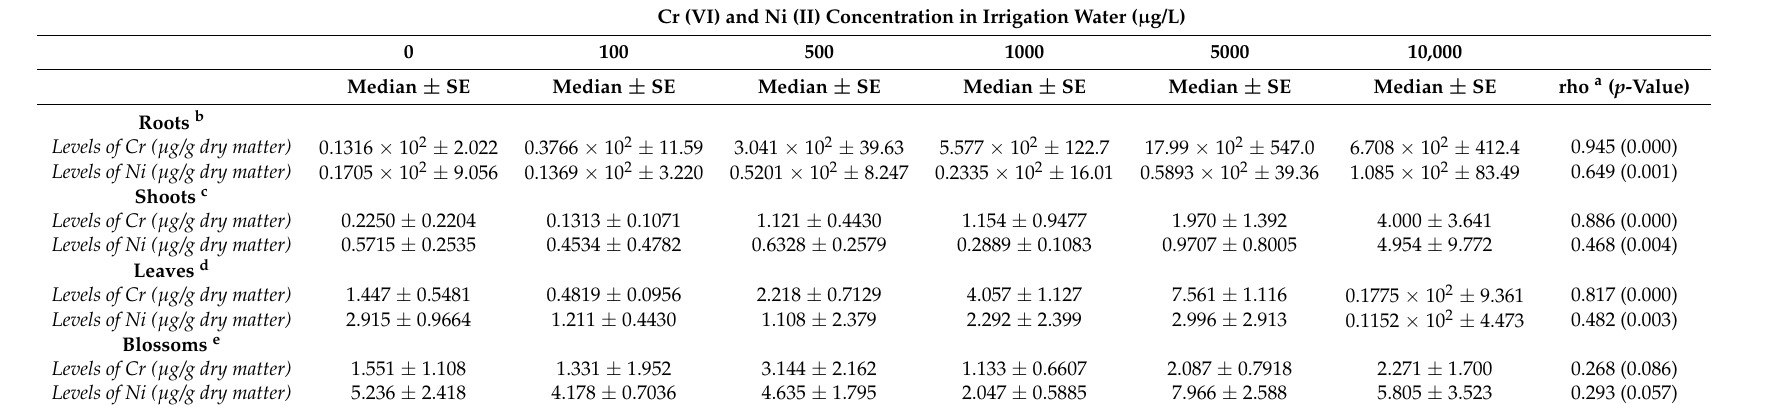
Table 1. Levels of Cr and Ni in plants by concentration in irrigation